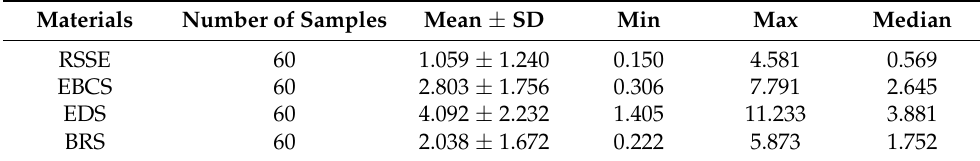
Table 3. Push-out strength values (MPa) of tested endodontic sealers.